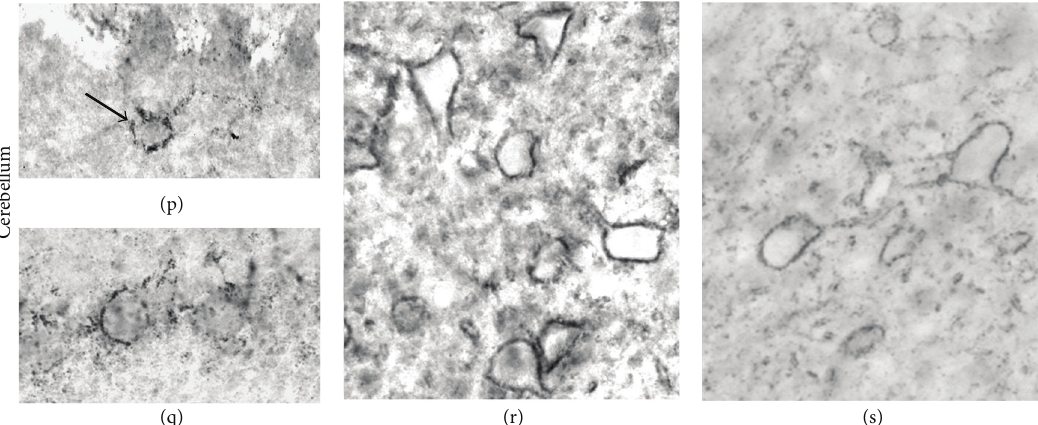
Figure 2: Sema3A expression in the rat brain from rostral to caudal. In the olfactory bulb (a), faint Sema3A-immunoreactive labeling was detected between mitral cells (arrowheads) as well as around the initial segments of the mitral cell dendrites in the external plexiform layer (arrow). A coronal section of the lateral olfactory tract (b) showed strong Sema3A-immunostaining in myelinated axons (arrowheads). In the reticular thalamic nucleus (c), intense diffuse labeling is present throughout the nucleus. The neurons in the reticular thalamic nucleus are surrounded by strongly Sema3A-labelled PNNs. Sema3A immunoreactivity in the hippocampus was observed in various structures. Interneurons in the stratum oriens of CA1 (so, arrow) (d) and in the stratum oriens (so, arrow) and stratum radiatum (sr, arrowhead) of CA2 (e) displayed Sema3A positive PNNs. Only the pyramidal neurons in CA2 and not in CA1 and CA3 displayed striking intense Sema3A- labelled PNNs with strong diffuse labeling between the cell bodies of pyramidal neurons (sps) (f). The polymorph layer (po) of the dentate gyrus displayed a weak diffuse staining for Sema3A. In the neocortex, neurons with a Sema3A-positive PNN are scattered throughout layers II to VI (g). This typical Sema3A labeling in the cortical layers was observed in various anatomical subdivisions of the neocortex, including the somatosensory cortex (h) and the visual cortex (i). Well defined Sema3A-labelled PNNs are present around neurons in the deep gray of the superior colliculus (j); this is in contrast to the weakly labelled PNNs surrounding the neurons of the intermediate gray of the superior colliculus (arrowheads) (k). The red nucleus shows a large number of strongly Sema3A-labelled PNNs around the magnocellular neurons. In addition, an intense diffuse Sema3A staining was observed between neurons (l). Also the external nucleus of the inferior colliculus displayed strong and well-defined Sema3A immunoreactive PNNs and strong diffuse labeling between the neurons throughout the nucleus (m). The vestibular nucleus of the hindbrain contains many large neurons with robust Sema3A-positive PNNs and strong diffuse immunoreactivity between the cells in the nucleus (n). Moderately Sema3A-labelled PNNs were observed around neurons in the inferior olive while throughout the nucleus a diffuse Sema3A labeling was present (o). In the cerebellum, some Golgi neurons bear Sema3A-positive PNNs ((p), arrow). Many Purkinje cells displayed a semiorganized Sema3A-pattern which is typical for the PNNs found around Purkinje cells (q). Deep cerebellar nuclei display well-defined large Sema3A and Sema3B immunoreactive neurons (resp., (r) and (s)). Images (d)–(s) have been reproduced with permission from Vo et al. [51]. Scale bar for (a) and (b) is 25 𝜇 m; for (c) and (j)–(o) is 100 𝜇 m; for (d)–(f) is 200 𝜇 m; for (g) is 300 𝜇 m; for (h) and (i) is 33 𝜇 m; and for (p)–(s) is 35 𝜇